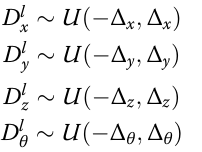
γ ¼ 0 : 15. Based on this γ value, the K ¼ 3 layer diffractive optical network shown in Fig. 6 provides 5.68%, 5.32%, 5.2% and 5.01% virtual fi lter array transmission ef fi ciency 0.425 THz and 0.45 THz, respectively. The forward model of a 3D-printed diffractive network is prone to physical errors, e.g., layer-to-layer misalign- ments. To mitigate the impact of these experimental error sources, such misalignments were modeled as random variables and incorporated into the forward training model so that the deep learning-based evolution of the diffractive surfaces is enforced to converge to solutions that show resilience against implementation errors 53 . Accordingly, the diffractive network design shown in Fig. 6 was vaccinated against random 3D layer-to-layer mis- alignments in the form of lateral and axial translations as well as in-plane rotations. For this, we introduced 4 uni- formly distributed random variables, D l , D l , D l and D l θ , x y z representing the random errors in the 3D location and orientation of a diffractive layer, l ,